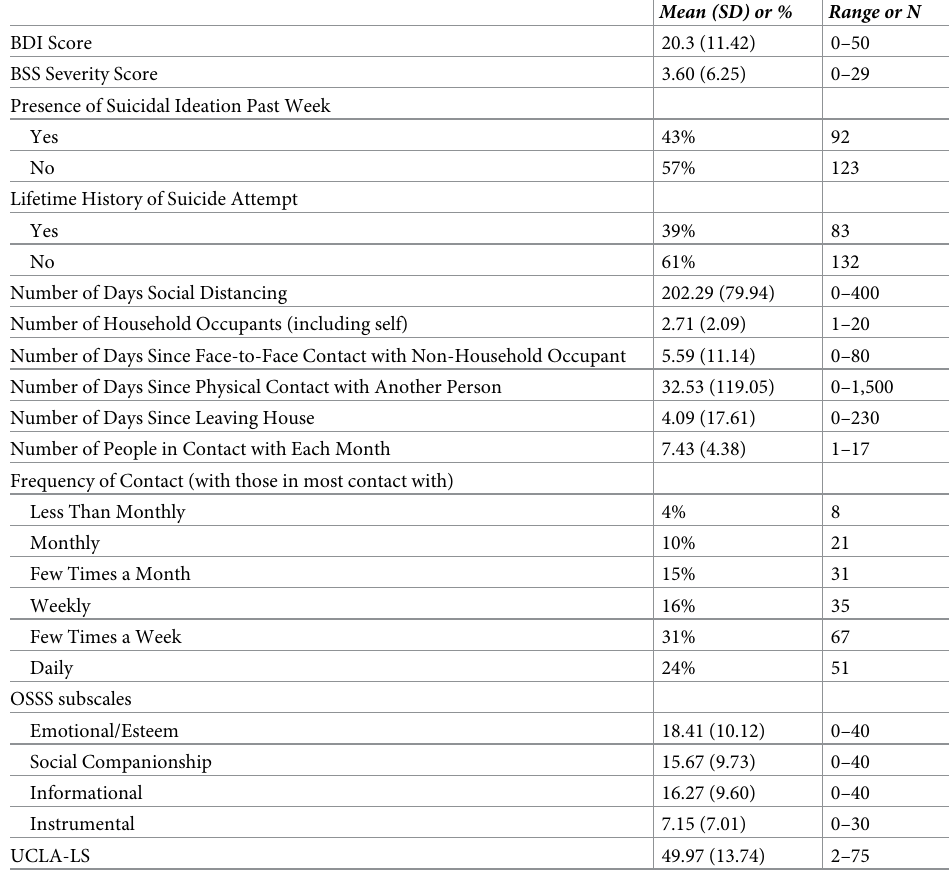
Table 2. Descriptive statistics for variables of